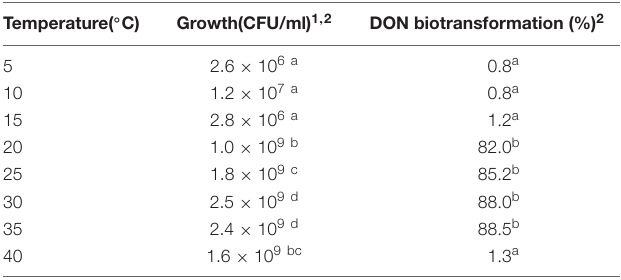
TABLE 1 | Growth and DON biotransformation activities of isolate 17-2-E-8 at selected cultivation temperatures. Temperature( ◦ C)